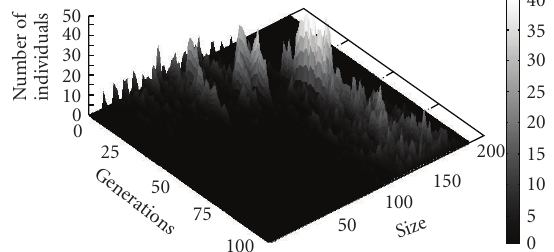
Figure 20: Parameter optimization Experiment 1: chromosome size in the population.